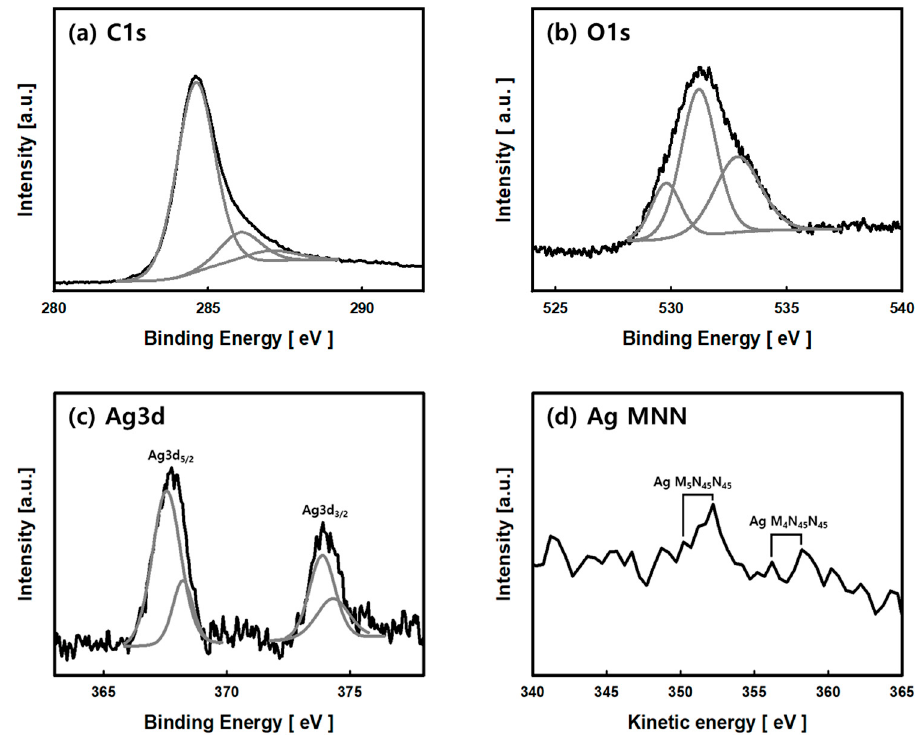
Figure 5. XPS spectra of the C1s region ( a ), O1s region ( b ), Ag3d region ( c ), and Ag NMM ( d ) of Ag/ACF-15 composite prepared by the LPP method.